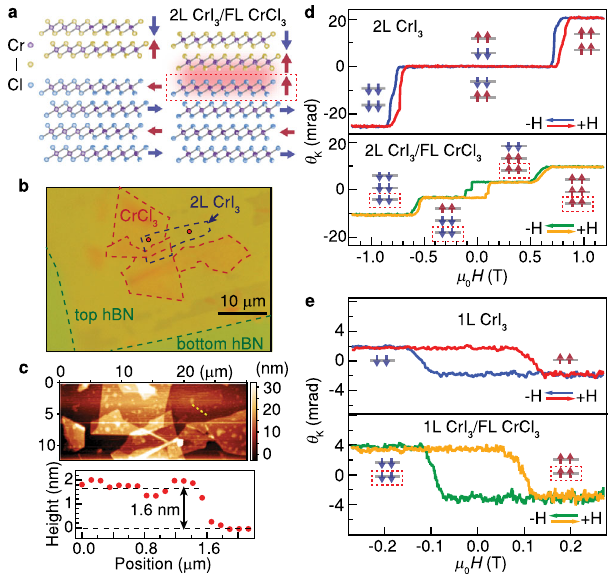
Fig. 1 | CrI 3 /CrCl 3 heterostructures and MOKE measurements. a Schematics of themagneticgroundstatesinbilayer(2L)CrI 3 andfew-layer(FL)CrCl 3 before(left) and after (right) forming heterostructure. Only four layers of CrCl 3 are shown for simplicity. b Optical micrograph of a 2L CrI 3 /FL CrCl 3 heterostructure. c Atomic force microscopy of the heterostructure in the same position as in b . The height pro fi le (along the yellow dotted line in the image) at the edge of CrI 3 indicates the thickness of a bilayer. d MOKE signal (after subtracting a polynomial background, asdoneforallMOKEcurvesinthemaintext)ofthe2LCrI 3 regionandthe2LCrI 3 /FL CrCl 3 heterostructure region as a function of perpendicular magnetic fi eld. Two curves of each region represent forward and backward sweeps of the fi eld, respectively. The data are taken at the spots marked by red in b . Insets depict